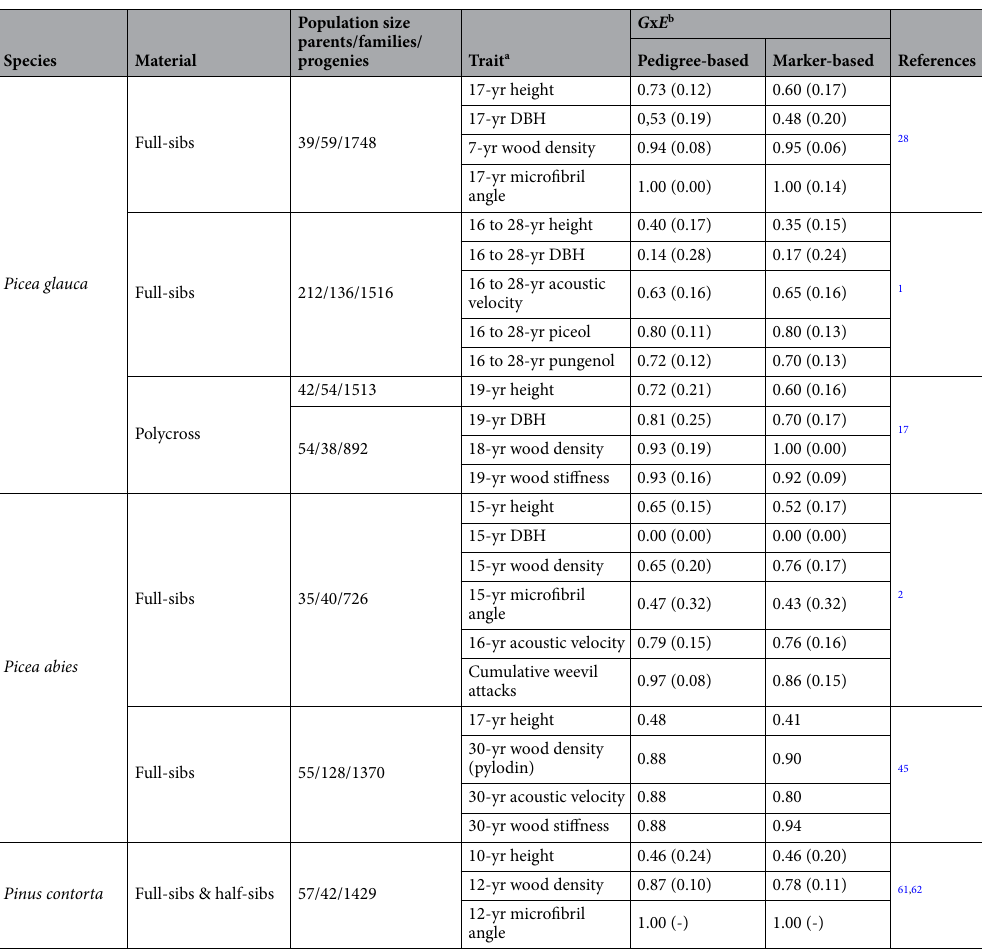
Table 2. Pedigree-based and marker-based estimates of genotype-by-environment ( G x E ) interaction for a variety of traits of conifer tree species. a DBH = diameter at breast height. b When reported in the original papers, standard errors in